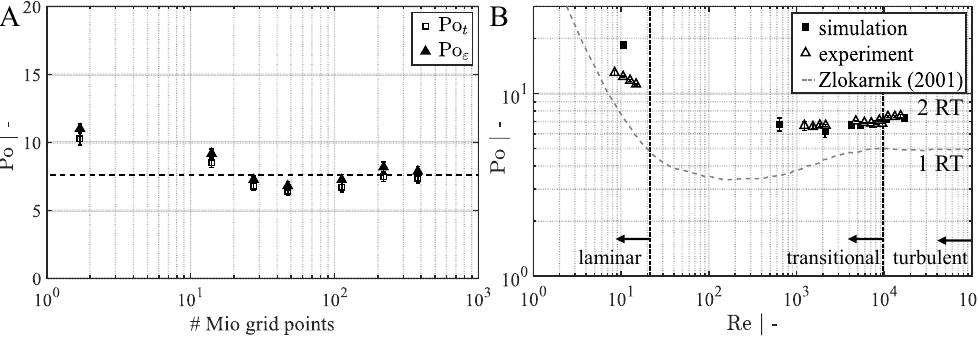
Figure 4. Evolution of power number Po determined by torque P t and by integral predicted energy dissipation P ε over number of grid points ( A ) with the experimental value of Po = 7.5 as dashed line (simulated average Po = 7.5 ± 0.5) and 𝑃𝑜 as function of Re for the baffled system ( B ).